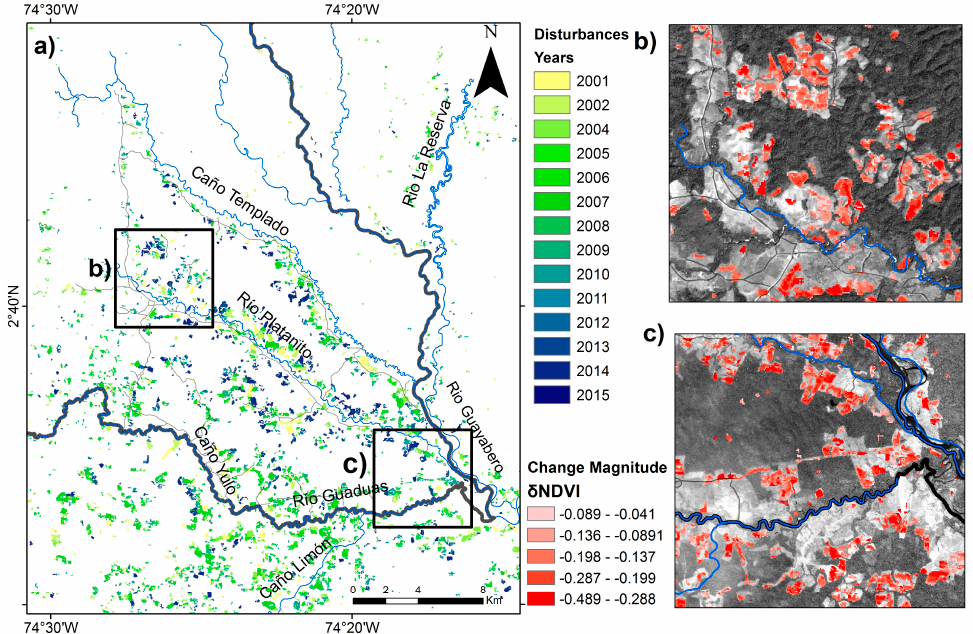
Figure 9. ( a ) Disturbance pattern in southeastern Picachos; ( b ) Change magnitude ( δ NDVI) subset over Platanillo sector and presence of unpaved roads (2015 RapidEye Red-Edge band background); ( c ) Subset for Rio Platanillo, Rio Guayabero, and Rio Guaduas (2014 RapidEye Red-Edge band background).